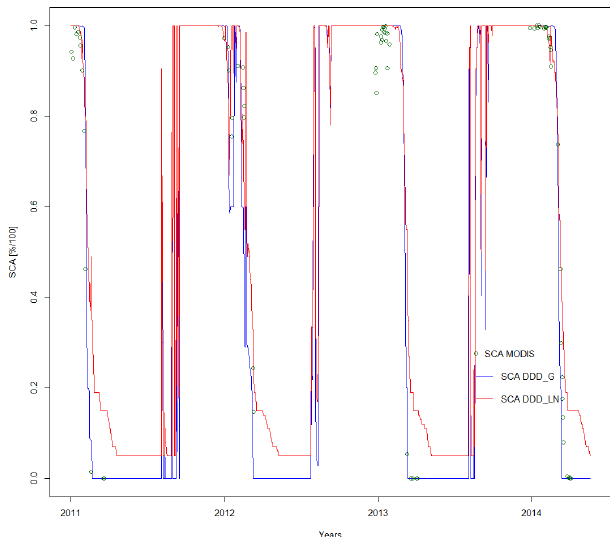
Figure 11. Time series of simulated SCA with DDD_G (blue) and DDD_LN (red) together with MODIS derived SCA (green circles) for catchment Tansvatn in Southern